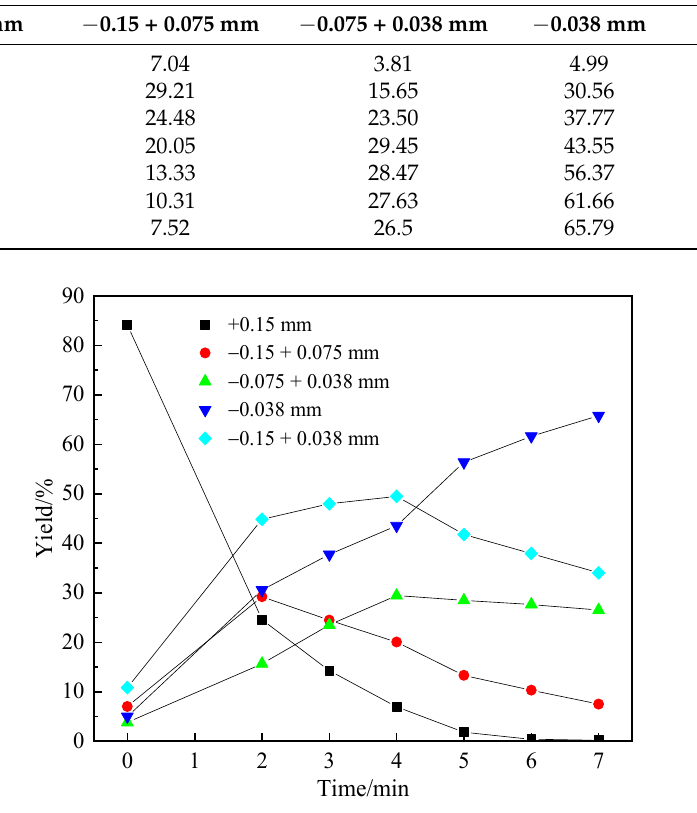
Figure 5. Particle size of grinding product at different grinding times.